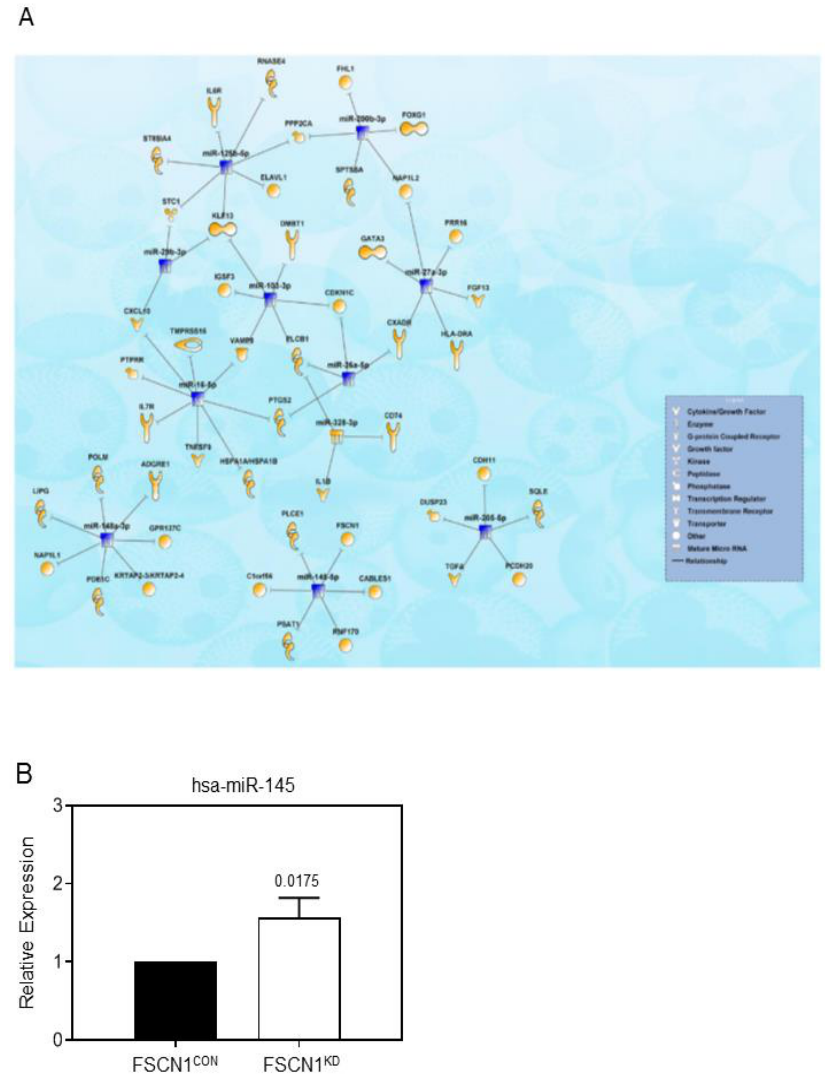
Figure 7. Network Analysis illustrating the interactions between differentially expressed miRNAs and mRNAs in FSCN1 KD MDA-MB-231 breast cancer cells. ( A ) Network illustrating the interaction between differentially expressed miRNAs and mRNAs in FSCN1 KD MDA-MB-231 based on IPA microRNA target filter analysis. ( B ) Bar graph showing relative RNA expression of hsa-miR-145 in FSCN1 KD compared to FSCN1 CON MDA-MB-231